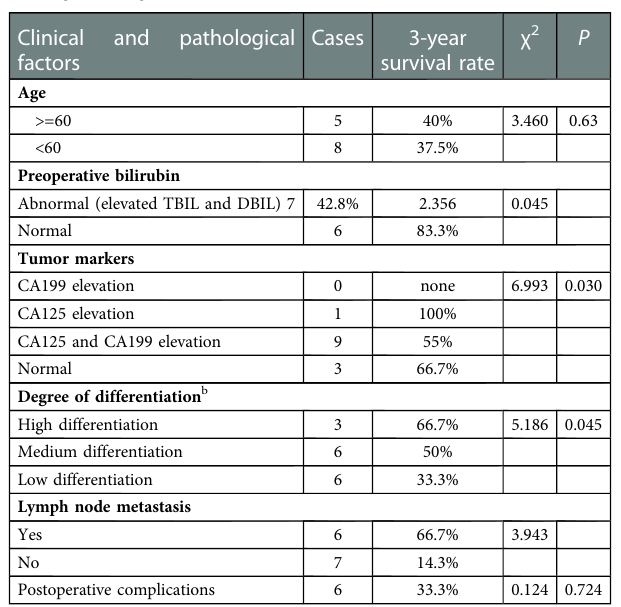
TABLE 2 Univariate analysis of prognostic factors in patients with gallbladder carcinoma undergoing liver 4B+5 segment